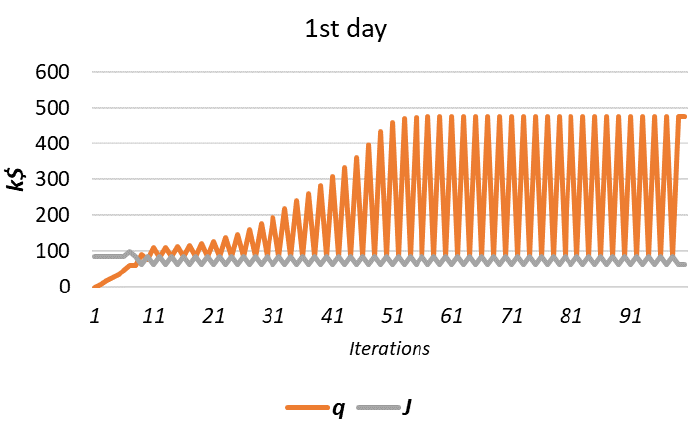
Figure 2. Performance of the conventional LR approach during the first 24 h residual demand. This corresponds to a TPC of 861.36 k$, obtained based on the following UC schedule (Figure 3).